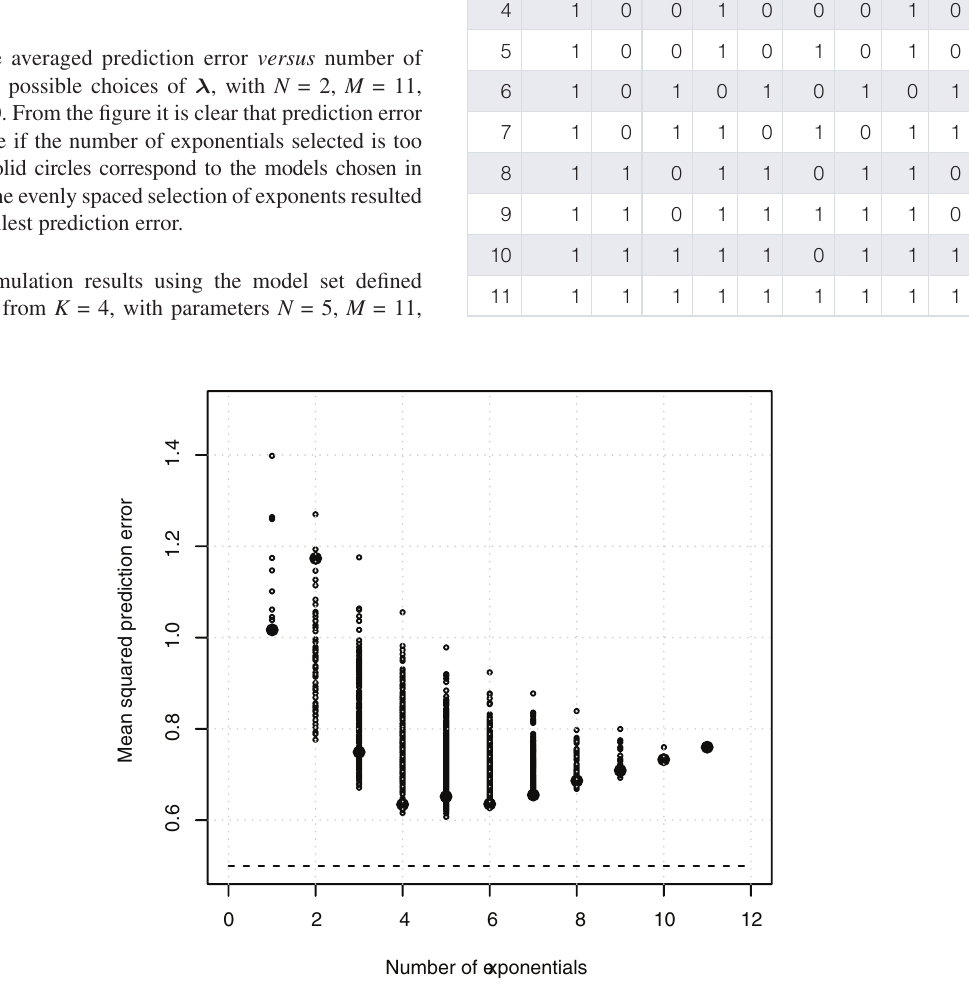
Figure 2. Mean squared prediction error ν 2 (equation (8)) as a function of the number of exponentials, with 2047 models, averaged over 100 runs, N = 2, M = 11, σ 2 = 0.5, ω 2 = 0. The dashed line represents the prediction error from the true model, so that ν 2 = σ 2 . The bigger solid circles correspond to the models chosen in Table